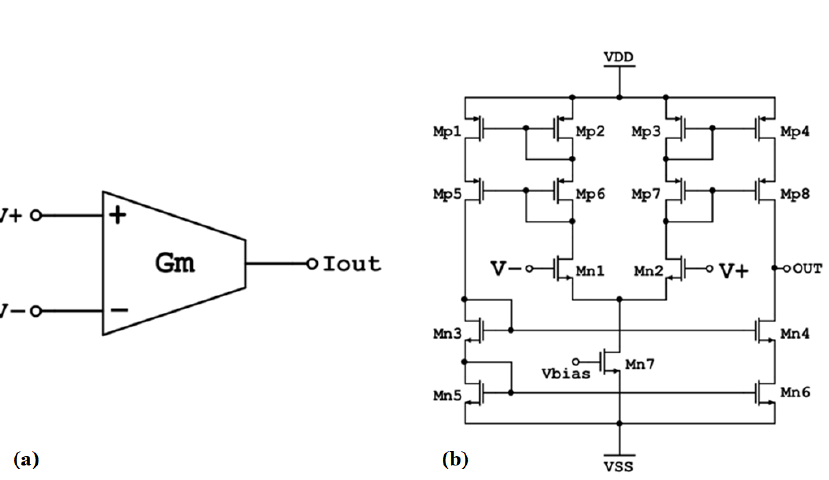
Figure 6. ( a ) Symbol of Operational Transconductance Amplifier (OTA) ( b ) Schematic of CMOS OTA.